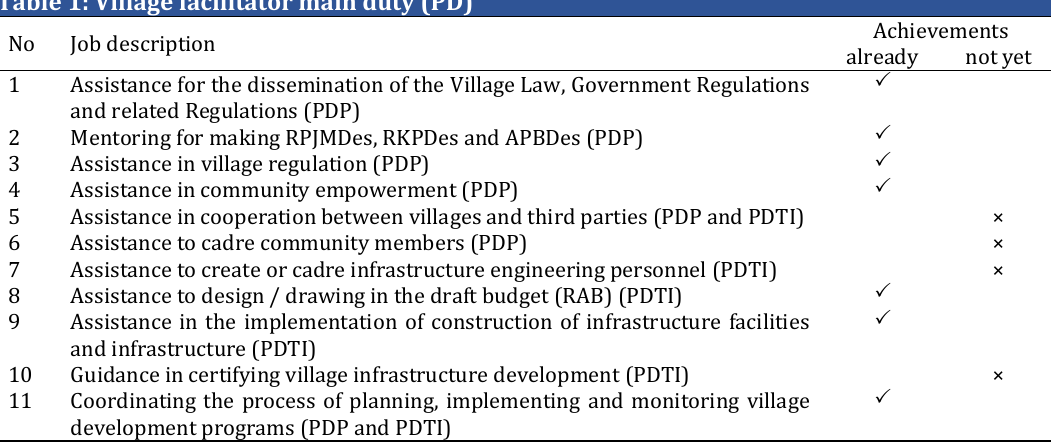
Table 1: Village facilitator main duty (PD)